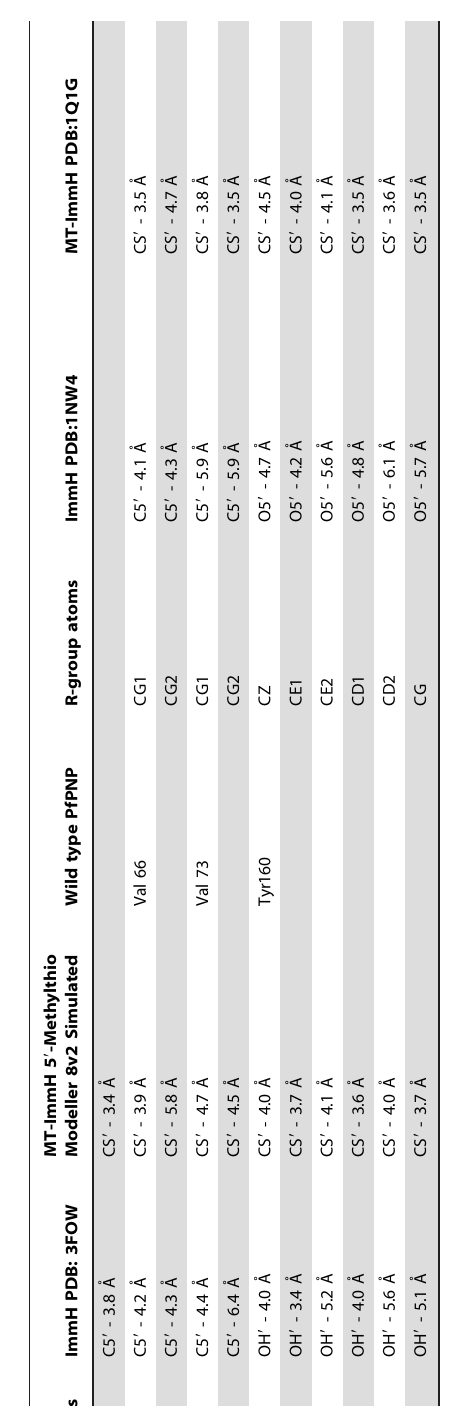
Figure S1 Secondary structure of wild-type and mutant PNPs. Circular dichroism of wild-type and mutant PfPNPs to compare secondary structure. Enzyme concentration for each run was 0.1 mg/ml (3.3 nM). Spectra was converted to molar ellipticity ( h ) after subtracting the solution of 10% HEPES buffer in water for baseline measured at 4 u C. Molar ellipticity conversion =